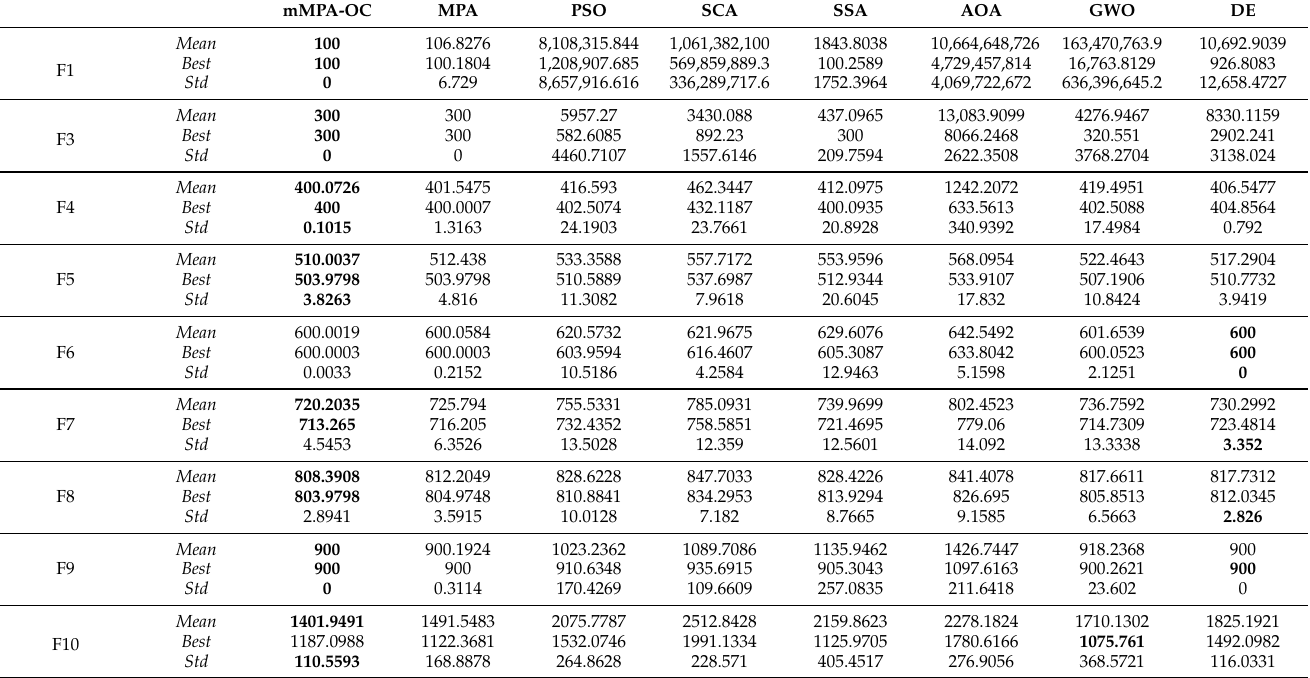
Table 3. Comparison of experimental results on single-peak and multi-peak functions of CEC-2017 (10